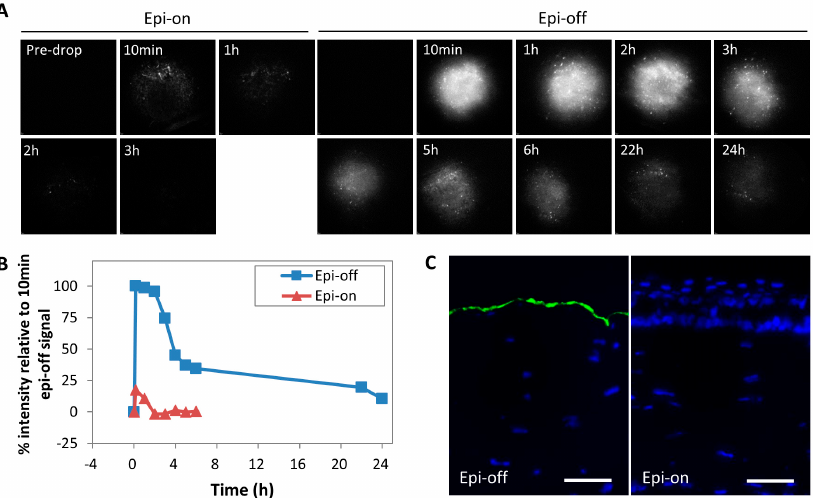
Figure 2. Time-lapse clearance of AlexaFluor 488-labeled MSc-exo to determine dosing of topical administration. ( A ) Fluorescent signals were detected using a confocal laser scanning ophthalmoscope. A rapid disappearance of signals (<1 h) was observed in epithelium-on corneas. Labeled MSC-exo applied to epithelium-off corneas showed signal retention for up to 24 h, with a time-dependent clearance of signals. ( B ) Signal intensity changes representing retention of AlexaFluor 488-labeled MSc-exo after topical application on rat corneas between epithelium-on and -off conditions (reference to peak intensity at 10 min on epithelium-off corneas). ( C ) Detection of labeled MSC-exo (green fluorescence) on epithelium-off corneal cryosections at 24 h. No fluorescent signal was detected from the epithelium-on corneas. DAPI (blue fluorescence) stained the nuclei. Scale bars: 100 µ